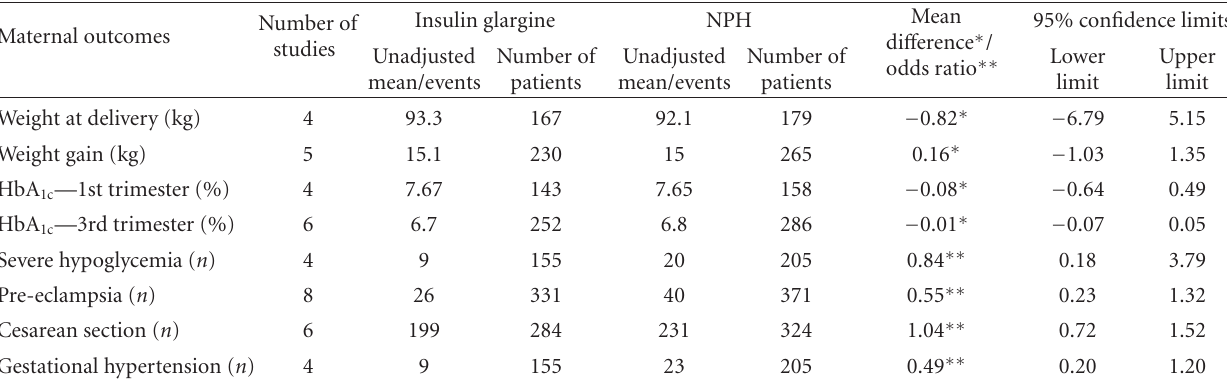
Table 3: Maternal outcomes of pregnant women using insulin glargine versus NPH among the studies selected for meta-analysis. Maternal